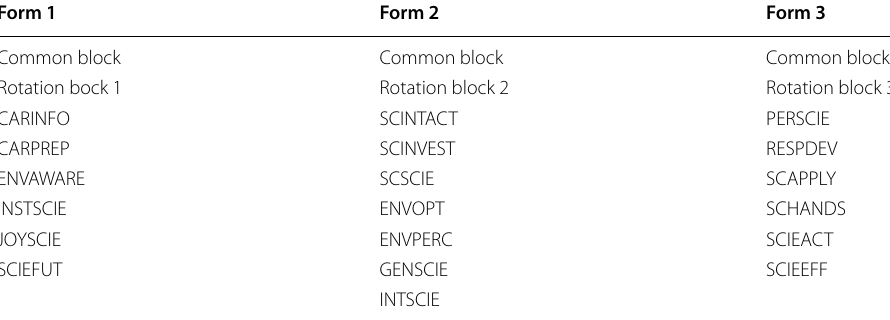
Scale definitions can be found in Table